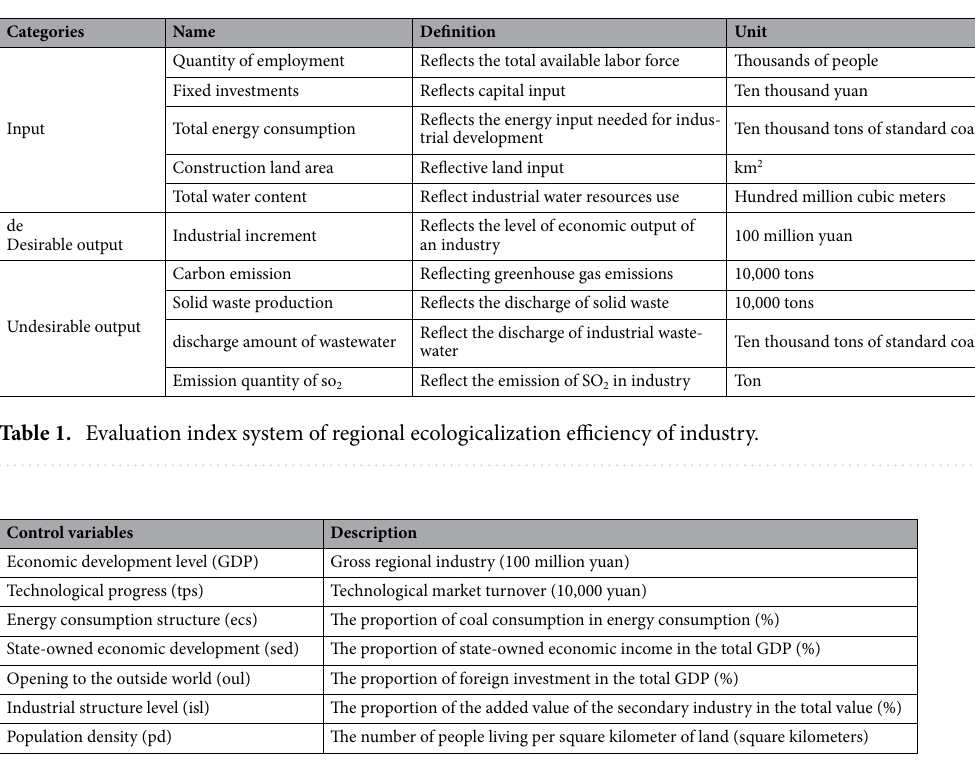
Table 2. Description of control